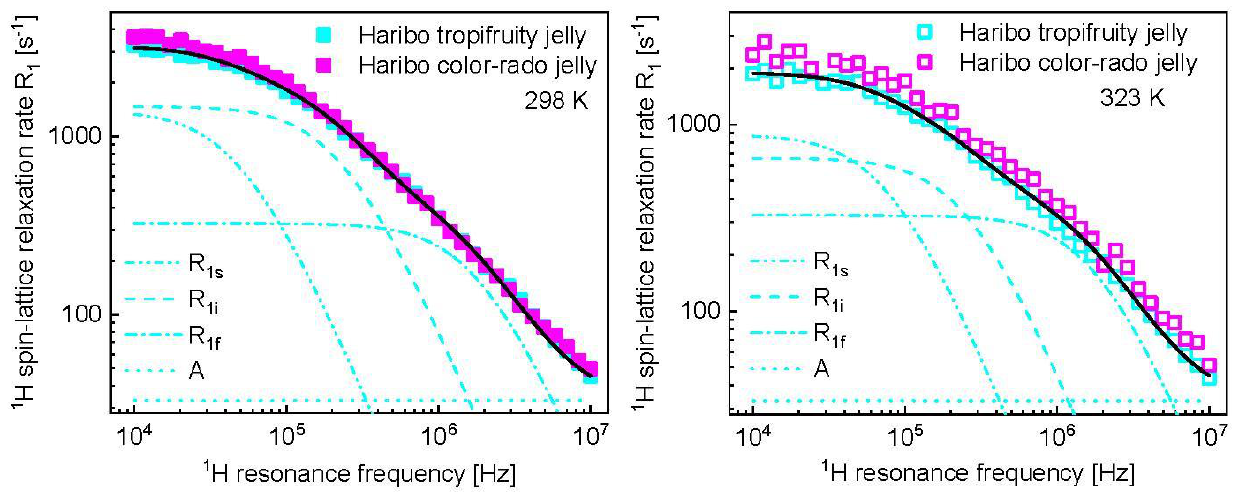
Figure A2. 1 H spin-lattice relaxation data for Haribo tropifruity jelly and Haribo color-rado jelly at 298 K ( left ) and 323 K ( right ) reproduced in terms of the model described in the theory. The fit ( R 1 ) shown as a black solid line has been decomposed into relaxation contributions associated with slow, intermediate and fast dynamics, R 1s , R 1i and R 1f , respectively. The frequency independent term, A , is also indicated.